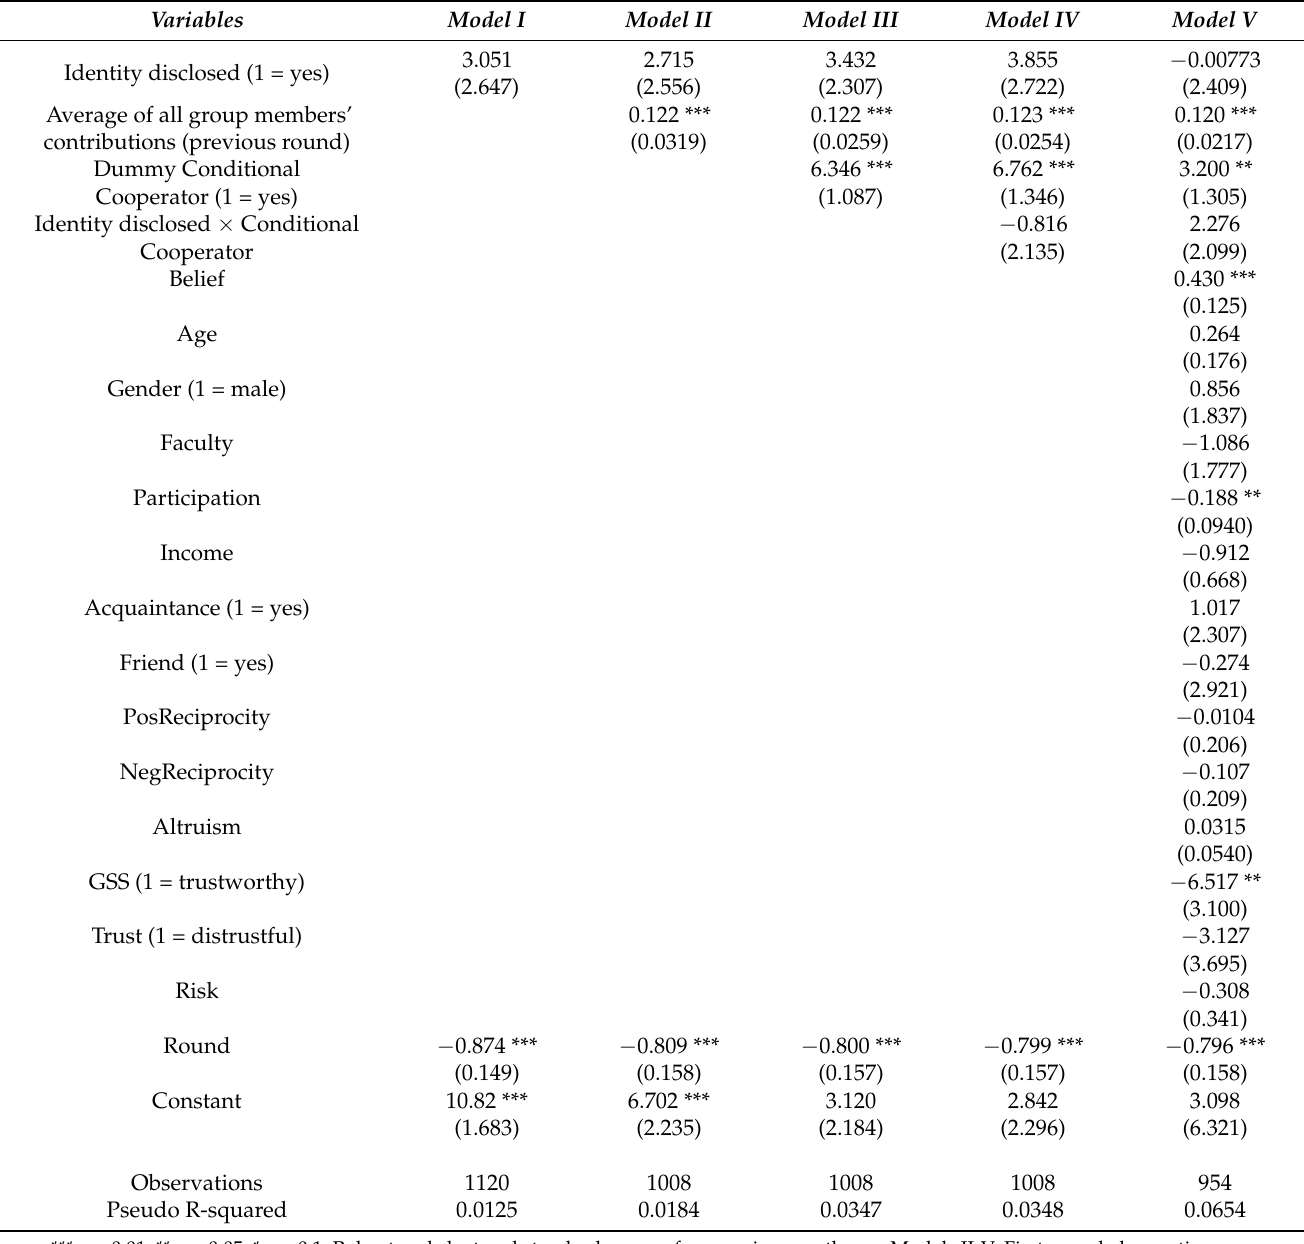
Table A7. IntDon setting: Tobit regression on individual contribution showing